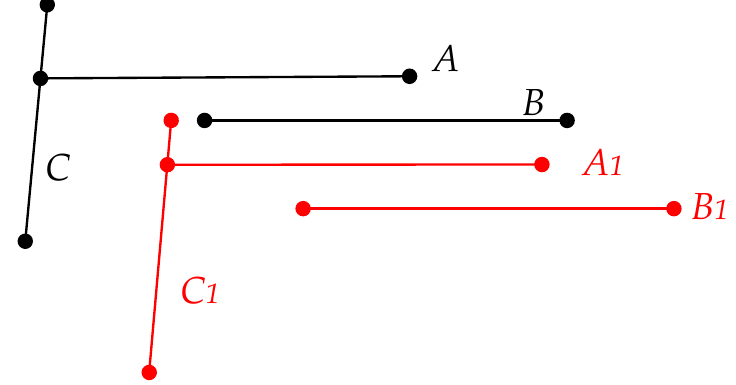
Figure 5. The importance of structural similarity. Strokes A , B , and C are two strokes from one dataset (black line), while A 1 , B 1 , and C 1 are from the other dataset (red line).